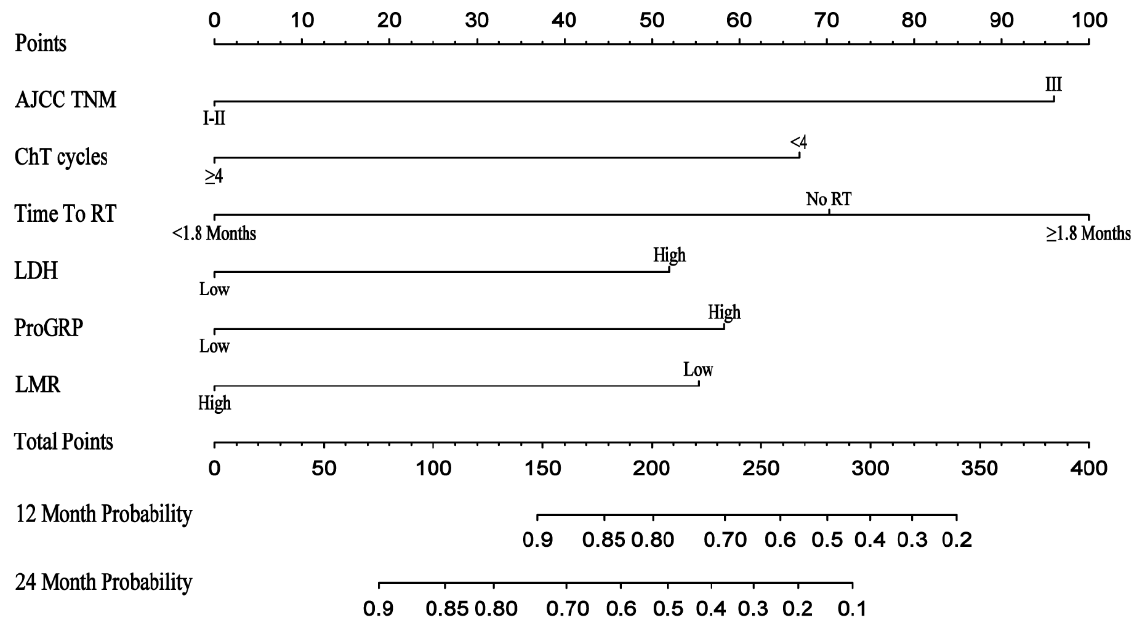
Figure 3. The nomogram was developed in the training cohort. ChT cycles , chemotherapy cycles; Time to RT , time from chemotherapy to radiotherapy; LDH , lactate dehydrogenase; ProGRP , pro- gastrin-releasing peptide precursor; LMR , lymphocytes–monocytes ratio.